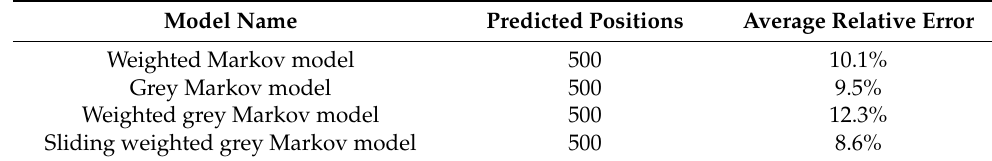
Table 15. Comparison of prediction accuracy of four